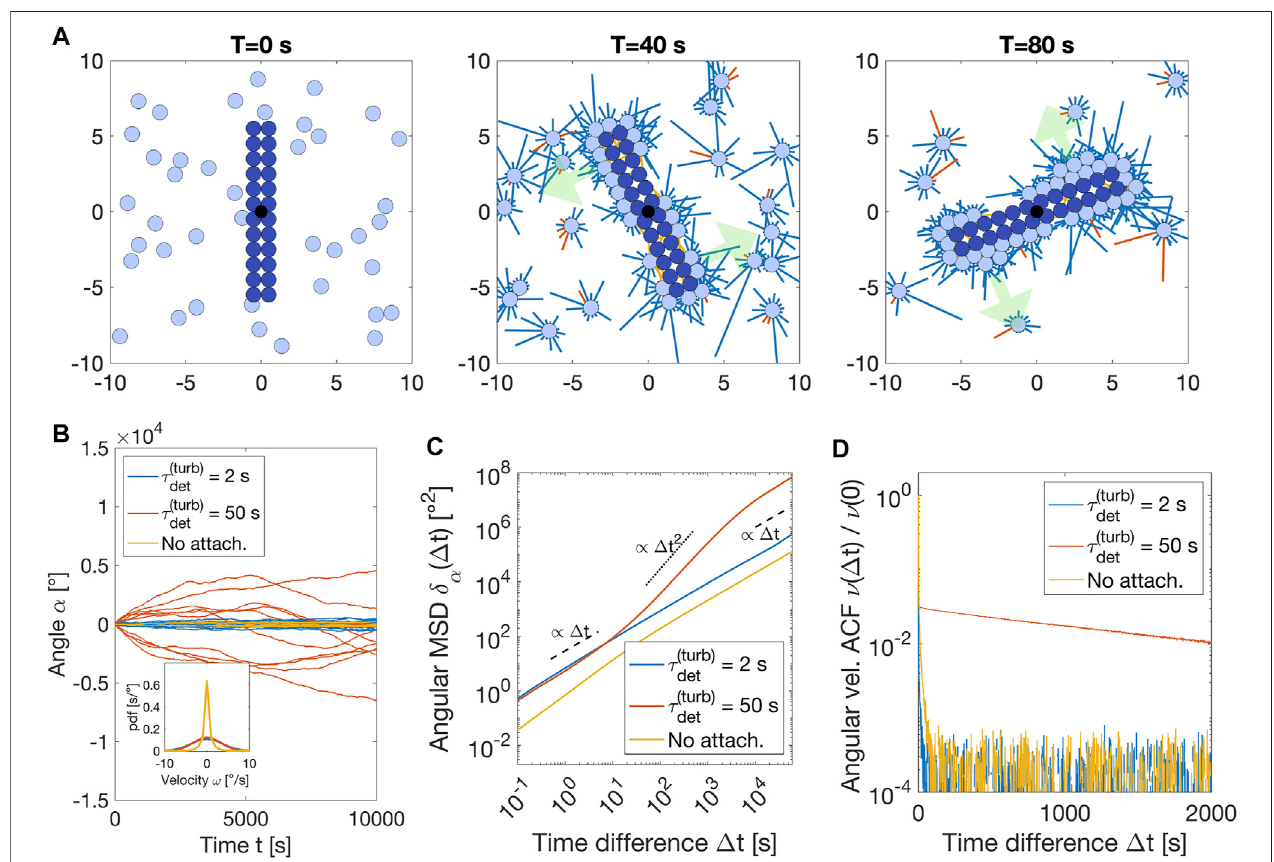
FIGURE2| Analysisofrotarymotionofaturbineinabathoftwitchingbacteria. (A) Snapshotsoftheinitialphaseofthesimulationsofaturbineinabathofbacteria with pili detachment rate τ ( turb ) det (cid:2) 50 s. Blue pili are not attached, orange pili are attached to the turbine and red pili are attached to the substrate. The green arrow indicates thedirection oftheturbinerotation. (B) Turbineangle α asafunction ofthetime t (see Figure 1B .).Theinset fi gure showstheprobabilitydensity functionofthe turbine angular velocity ω . (C) Angular mean squared displacement (angular MSD) ofthe turbine angle, see Eq. 11 . (D) Normalised angular velocity autocorrelation function of the turbine angle, see Eq. 12